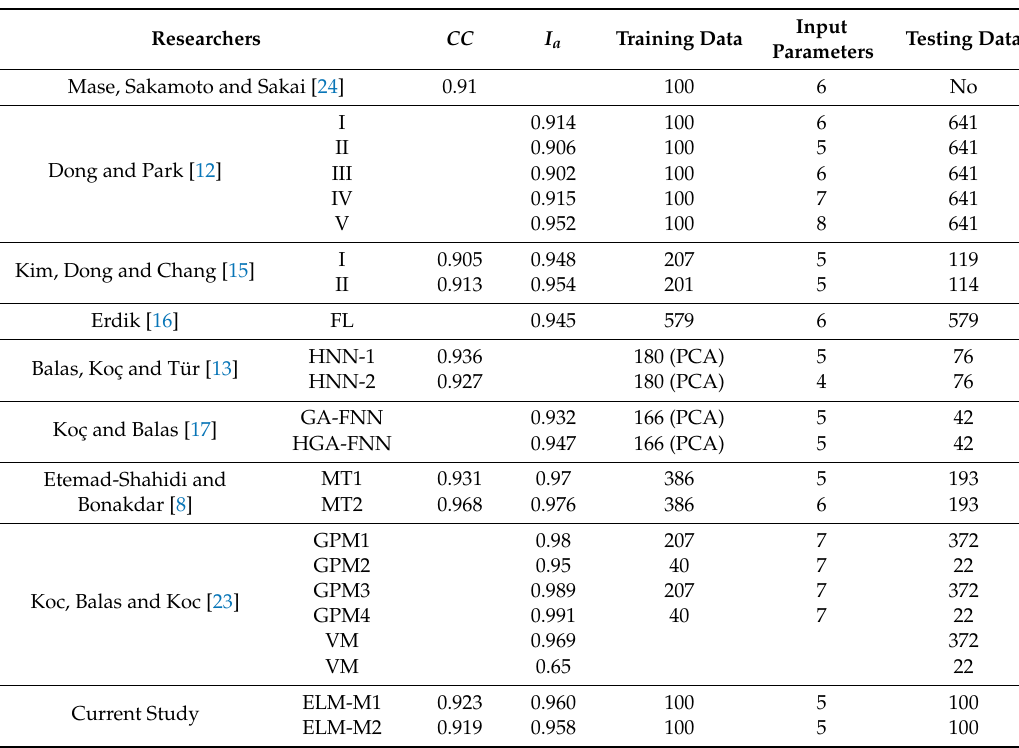
Table 5. Calculation details of di ff erent machine learning